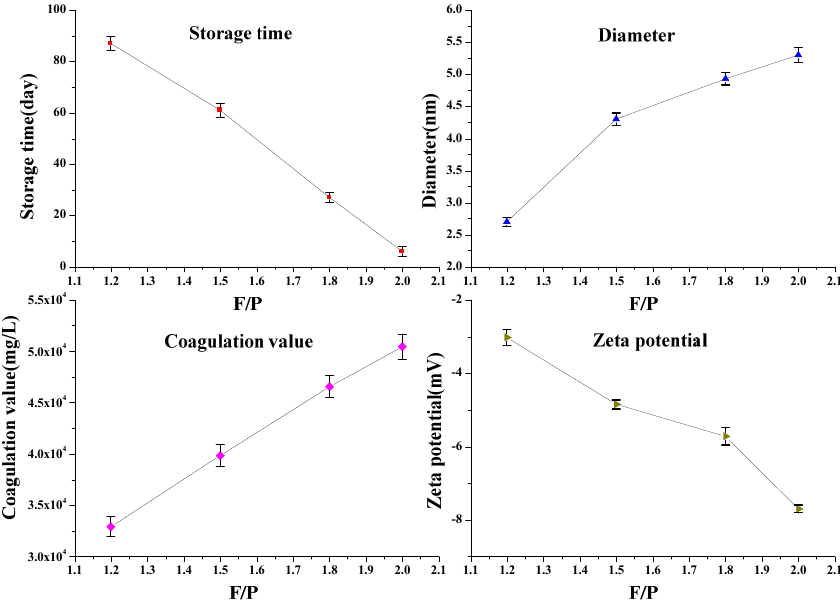
Figure 9. Effects of F/P on the SPF resin properties (mean ± s.d., n = 3 per condition).